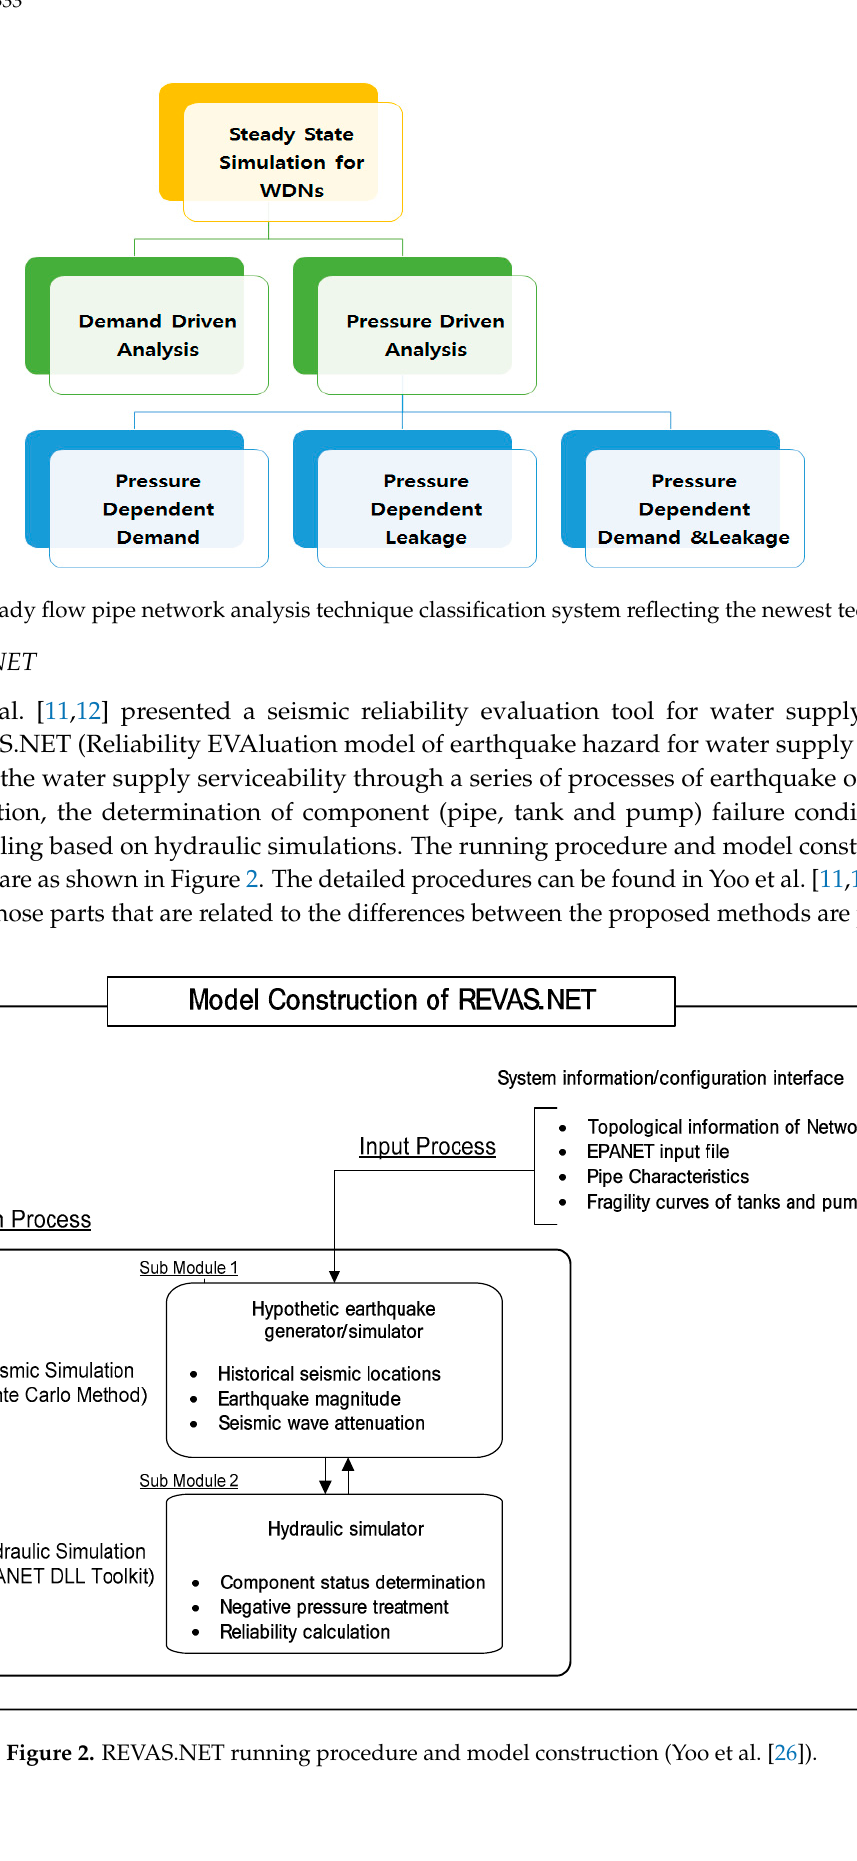
Figure 2. REVAS.NET running procedure and model construction (Yoo et al. [26]).